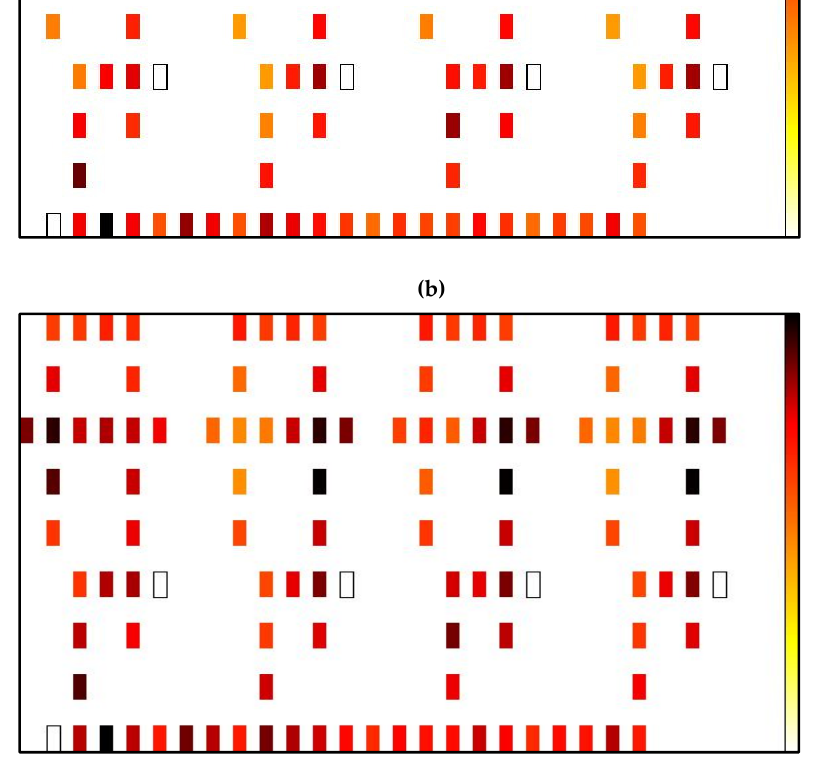
Figure 24. Map of energy dissipation for proposed 4-bit PIPO shift register at T = 2K and ( a ) 0.5 Ek, ( b ) 1.0 Ek, ( c ) 1.5 Ek γ -factor.